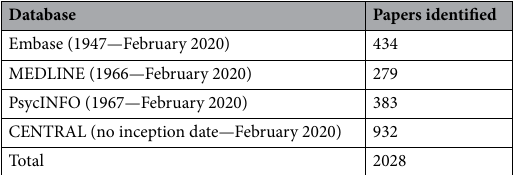
Table 1. Electronic databases searched and number of